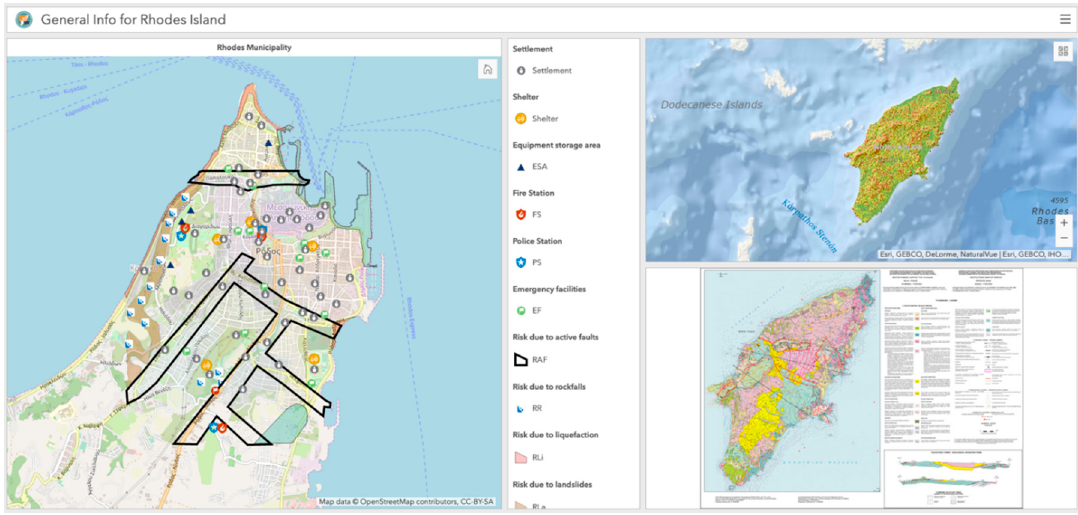
Figure 3. Interactive dashboard presenting information for seismic risk management for Rhodes Island (https://arcg.is/1Ka98C0).